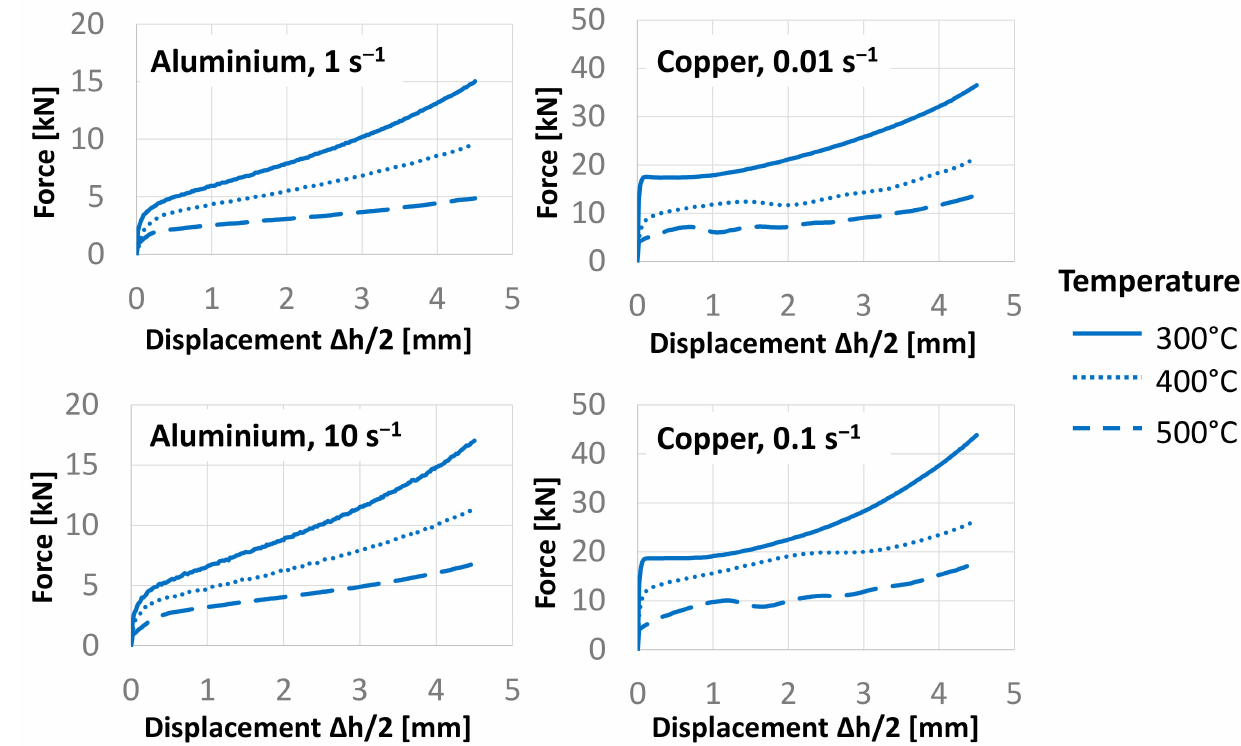
Figure 6. Example force displacement (FD) curves for aluminum and copper at three temperatures and two strain